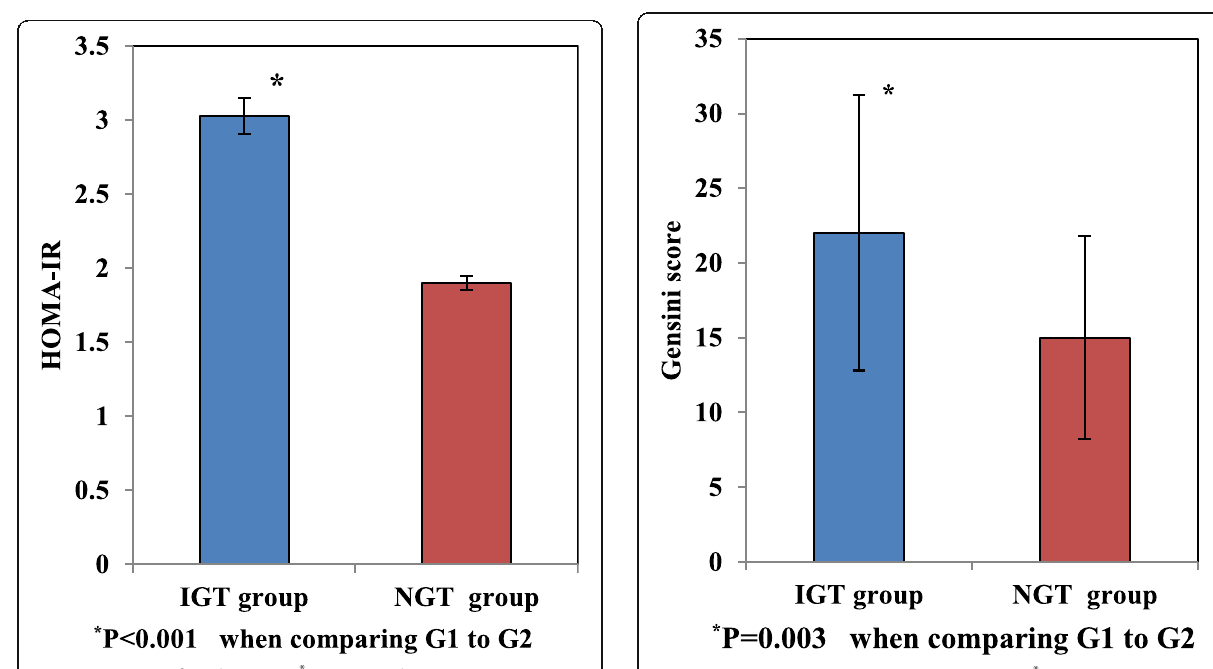
Fig. 2 Modified Gensini score of study groups. * P = 0.003 when comparing G1 to